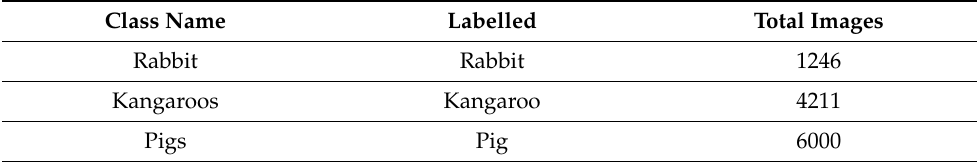
Figure 2. An example of data annotation/labelling performed for different animal species in our dataset. Table 2. Dataset used for training